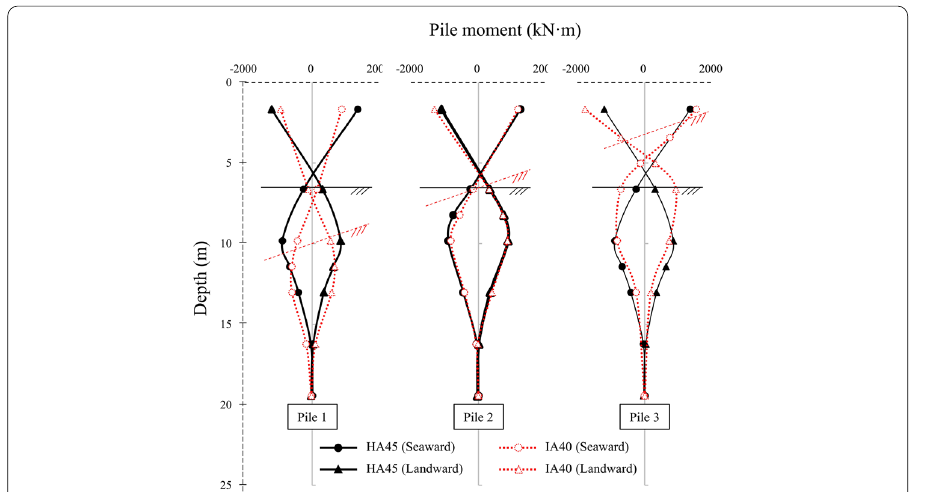
Fig. 7 Depth profiles of the pile moments of HA45 and IA40